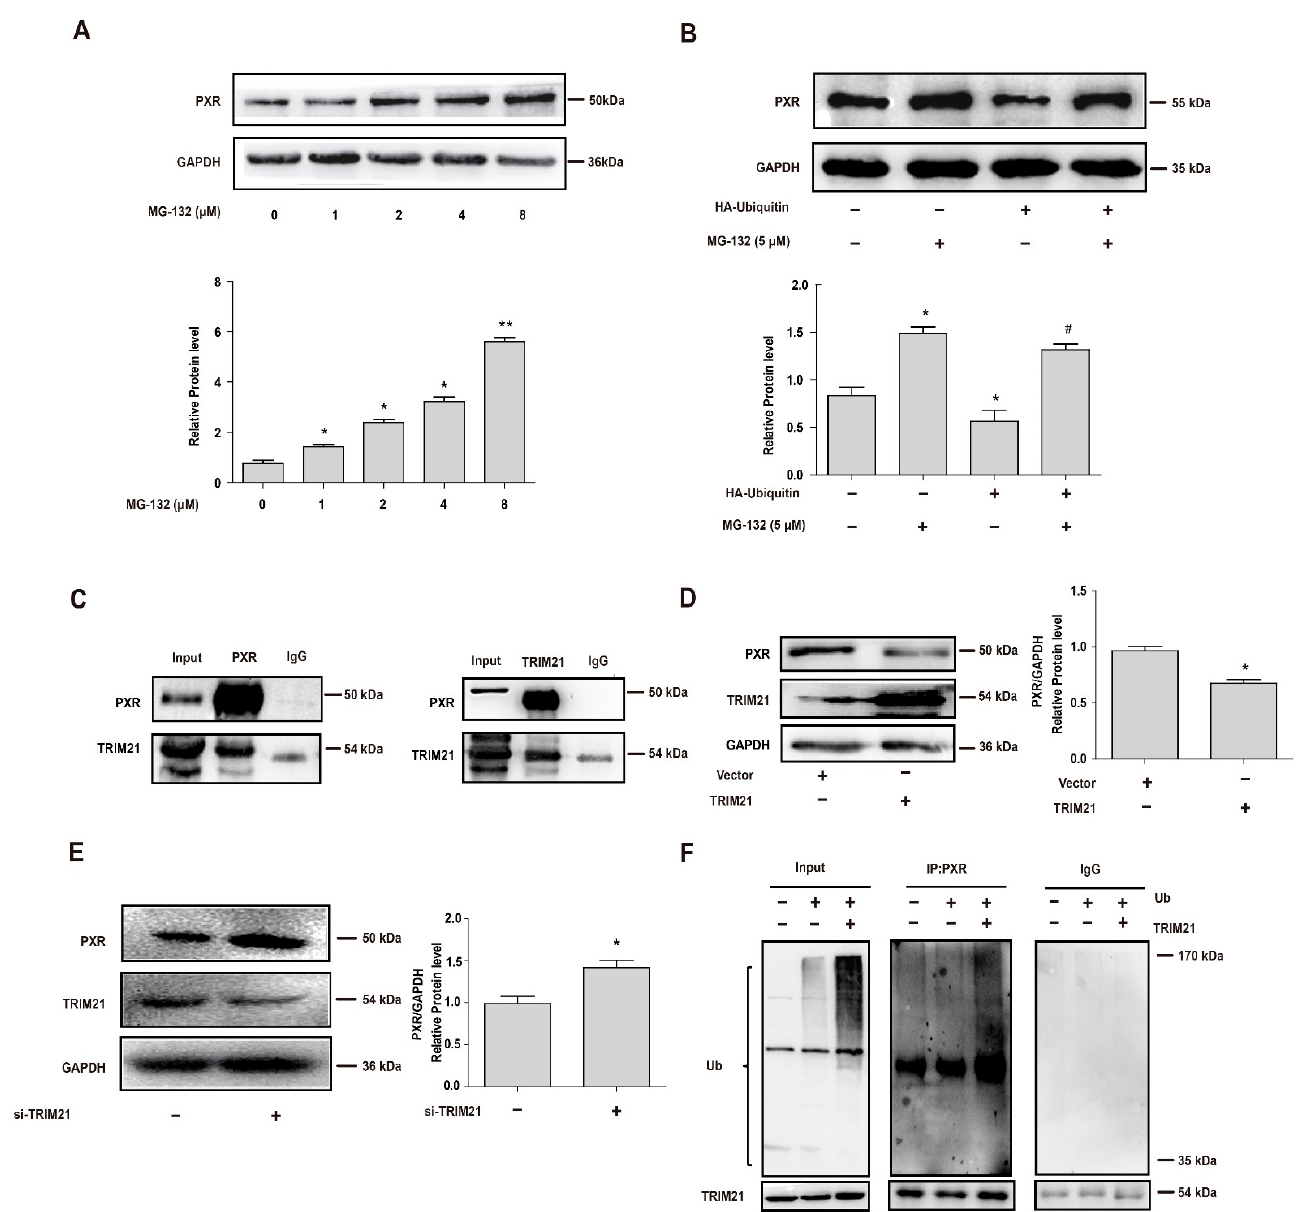
Figure 1. The E3 ligase TRIM21 binds to PXR and mediates its ubiquitination and degradation. ( A ) HepG2 cells were treated with MG-132 (0, 1, 2, 4 or 8 μ M) for 6 h in the presence of CHX (10 μ M), and PXR protein levels were determined by Western blot. ( B ) HEK 293T cells were transfected with HA-ubiquitin for 24 h and then treated with or without MG- 132 5 μ M for 24 h, and PXR protein levels were determined by Western blot. ( C ) Interaction of TRIM21 with PXR. HEK 293T cells were transfected with PXR and TRIM21 constructs as indicated. Cell extracts were immunoprecipitated using PXR antibody or IgG and probed with TRIM21 (left). Reciprocally, the extracts were immunoprecipitated with TRIM21 antibody or IgG and probed with PXR antibody (right). ( D ) Ectopic overexpression of TRIM21 in HepG2 cells decreased endogenous PXR levels. HepG2 cells were transfected with TRIM21 construct, and the protein level of PXR was analyzed by Western blot 48 h later. ( E ) HepG2 cells were transfected with siTRIM21 and siRNA-control for 48 h. Cell lysates were prepared and subjected to Western blot to determine the expression of PXR and TRIM21, respectively. ( F ) TRIM21 ubiq- uitinates PXR. HEK 293T cells were transfected with corresponding vector or HA-Ubiquitin with or without the co-trans- fection of TRIM21 as indicated. After 24 h, cells were treated with MG-132 (5 μ M) for 24 h. Cell lysates were immunopre- cipitated with PXR antibody (IP: PXR) or IgG, subjected to Western blot, and probed with anti-HA antibody to detect ubiquitination of PXR. The ubiquitinated ladder was more pronounced when the cells were transfected with ubiquitin and TRIM21 together, compared with those transfected with ubiquitin alone. Experiments described in this figure were